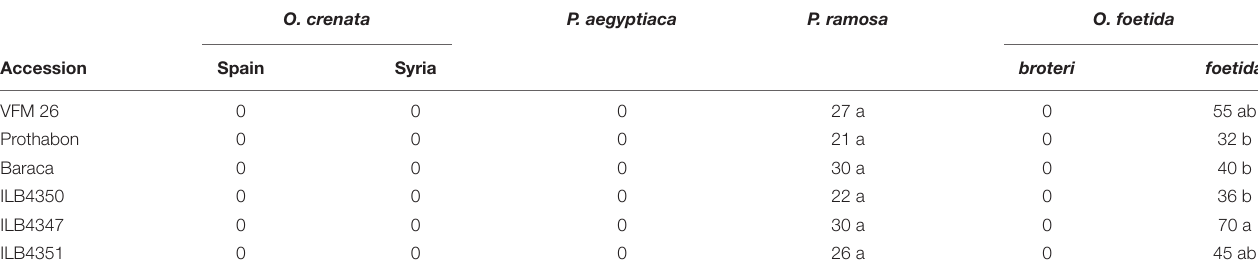
TABLE 4 | Percentage of broomrape radicles showing negative tropism when approaching roots of faba bean